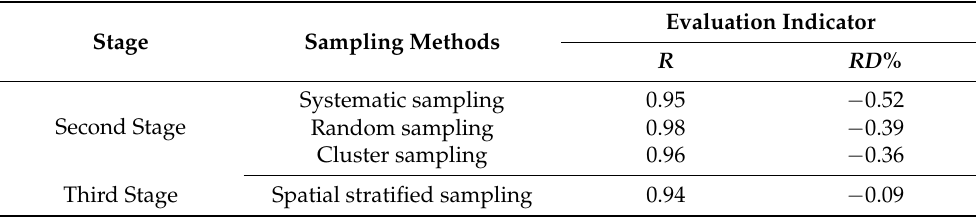
Table 6. Accuracy analysis of the forest volume estimation using various sampling